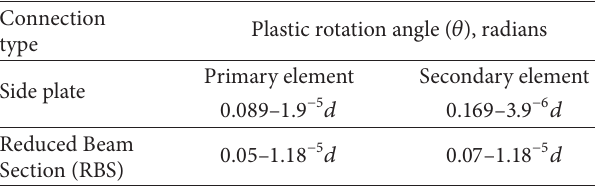
Table 2: Acceptance criteria for fully restrained moment connec- tions